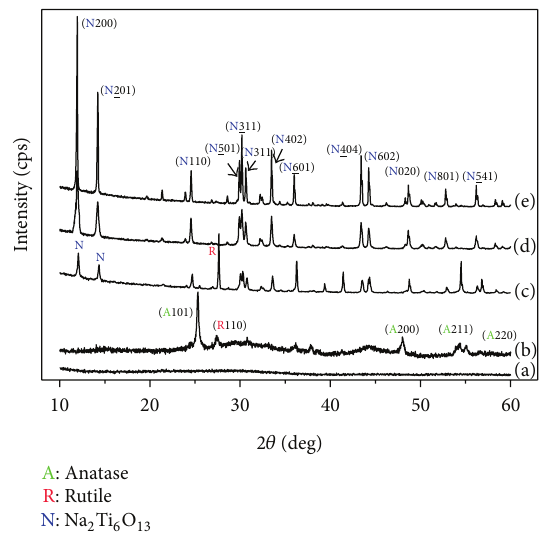
Figure 3: XRD pattern of 1.5-Na 2 Ti 6 O 13 /TiO 2 composite par- ticles: (a) 1.5-Na 2 Ti 6 O 13 /TiO 2 precursor; (b) 1.5-Na 2 Ti 6 O 13 /TiO 2 calcined at 500 ∘ C; (c) 1.5-Na 2 Ti 6 O 13 /TiO 2 calcined at 600 ∘ C; (d) 1.5- Na 2 Ti 6 O 13 /TiO 2 calcined at 700 ∘ C; (e) 1.5-Na 2 Ti 6 O 13 /TiO 2 calcined at 800 ∘ C.